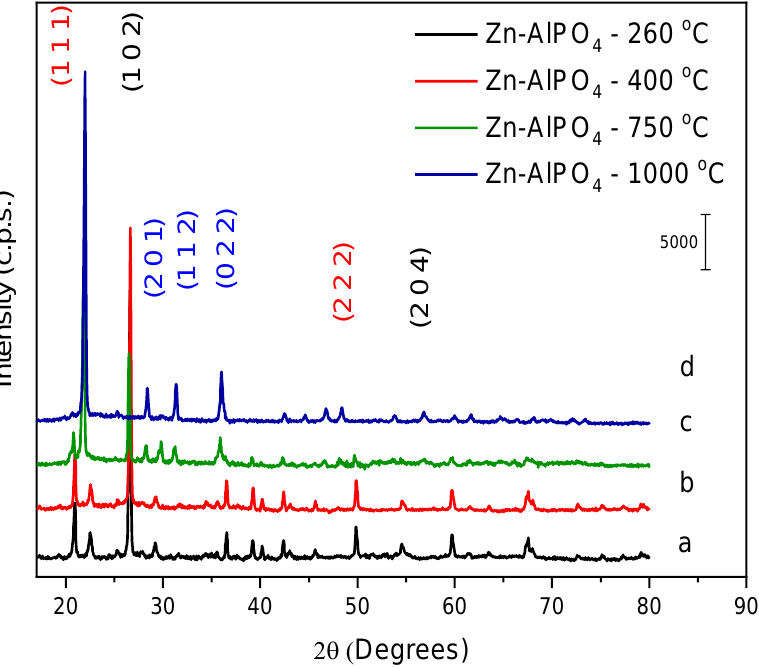
Figure 5. Powder X-ray diffractograms of the Zn-AlPO 4 samples heat-treated at ( a ) 260, ( b ) 400, ( c ) 750, and ( d ) 1000 °C.